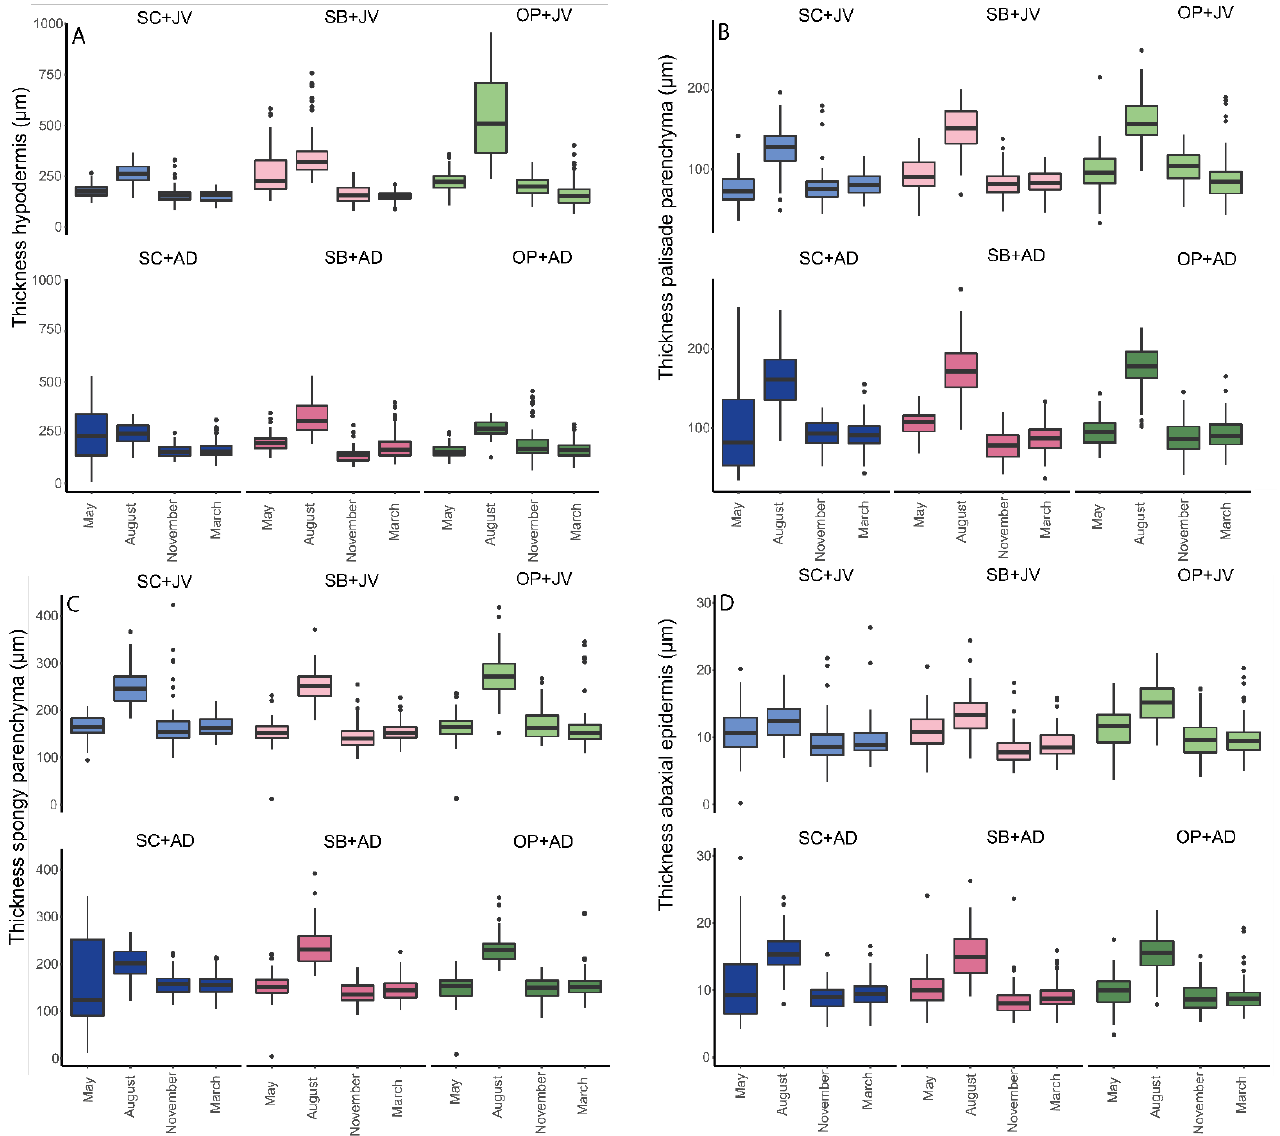
Figure 5. Morphoanatomical traits measured in juveniles and adults of R. mangle during four periods. ( A ) Thickness hypodermis SC + JV: n = 324, SB + JV: n = 324, OP + JV: n = 326, SC + AD: n = 325, SB + AD: n = 324, OP + AD: n = 320. ( B ) Thickness palisade parenchyma. SC + JV: n = 324, SB + JV: n = 324, OP + JV: n = 326, SC + AD: n = 325, SB + AD: n =